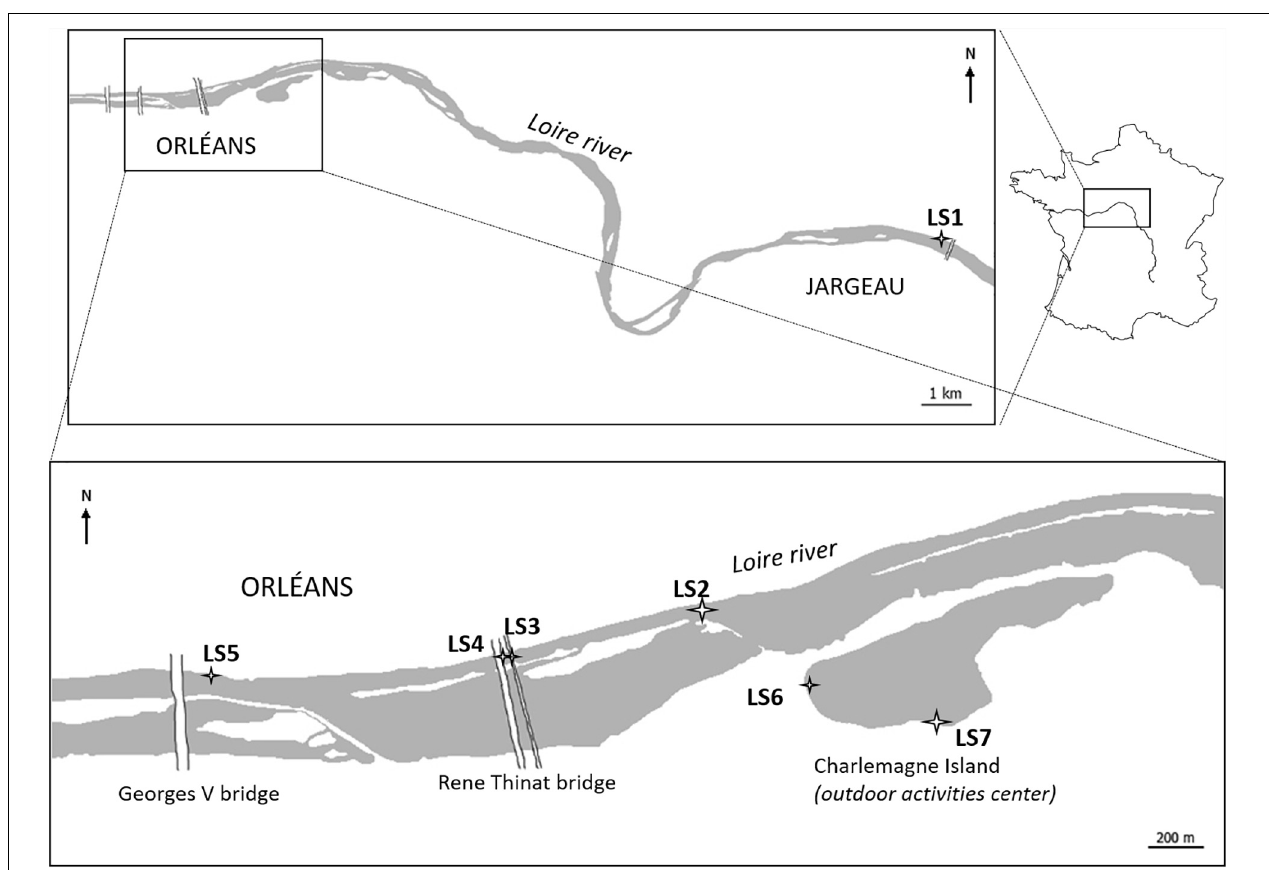
FIGURE 1 | Loire River sampling sites from LS1 (in Jargeau city) to LS7, in Orleans city.